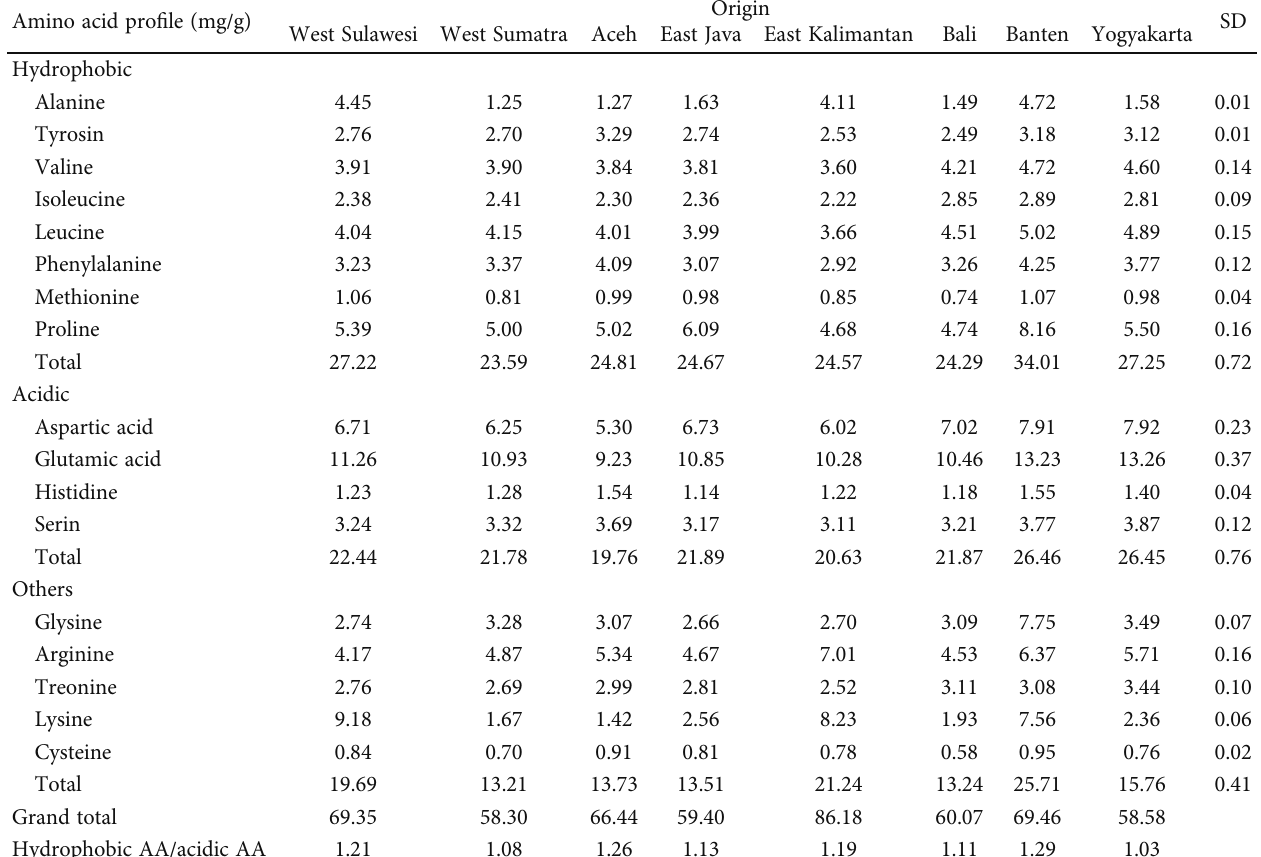
Table 3: Fermented cocoa bean amino acid pro fi le from various regions in